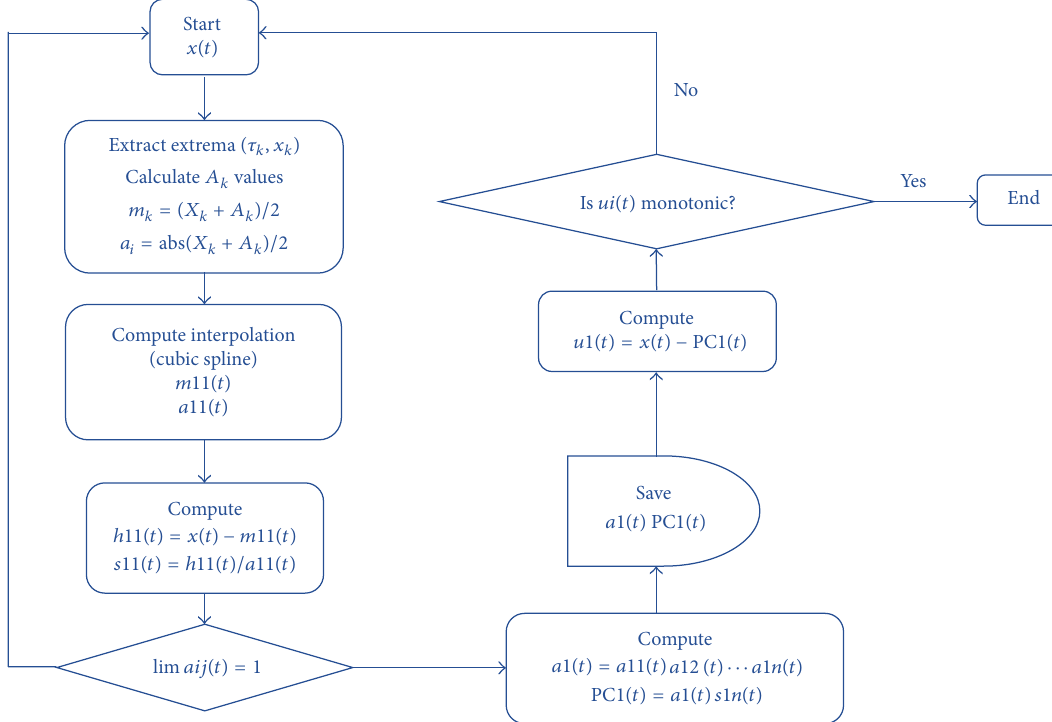
Figure 4: Flow chart of the ICD